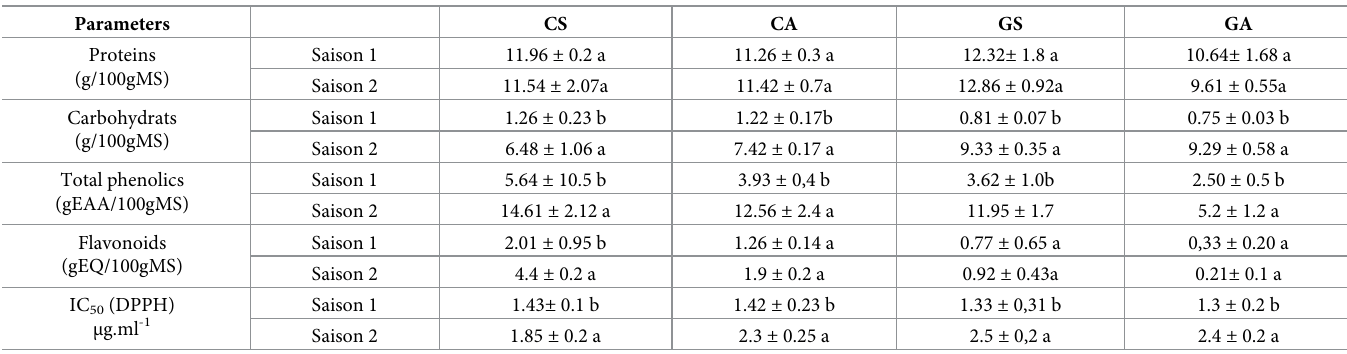
Table 2. Effect of season on bioactive compounds.